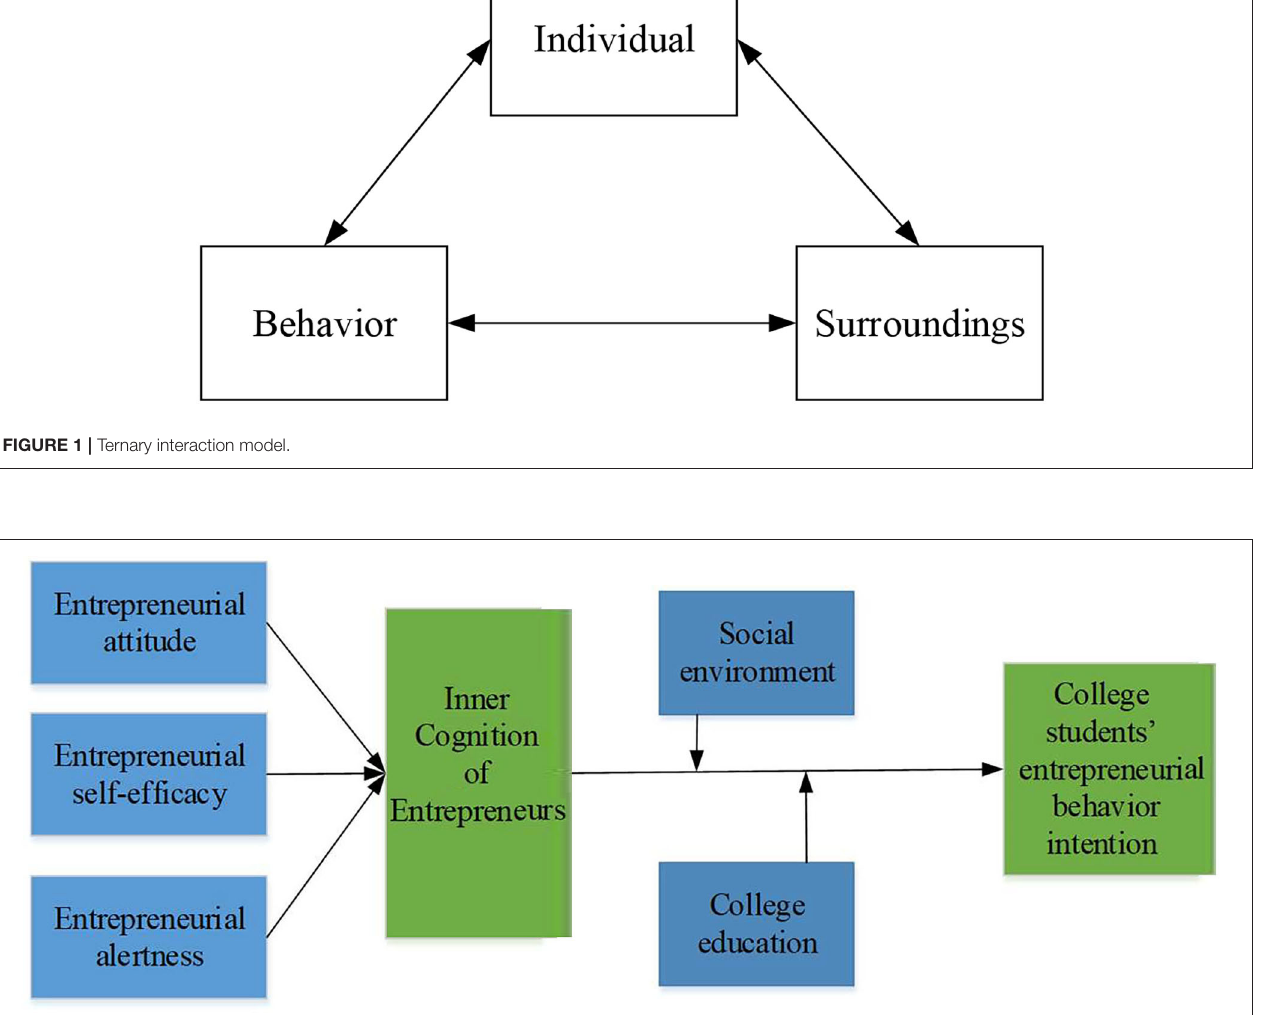
FIGURE 2 | College students’ entrepreneurial behavior intention